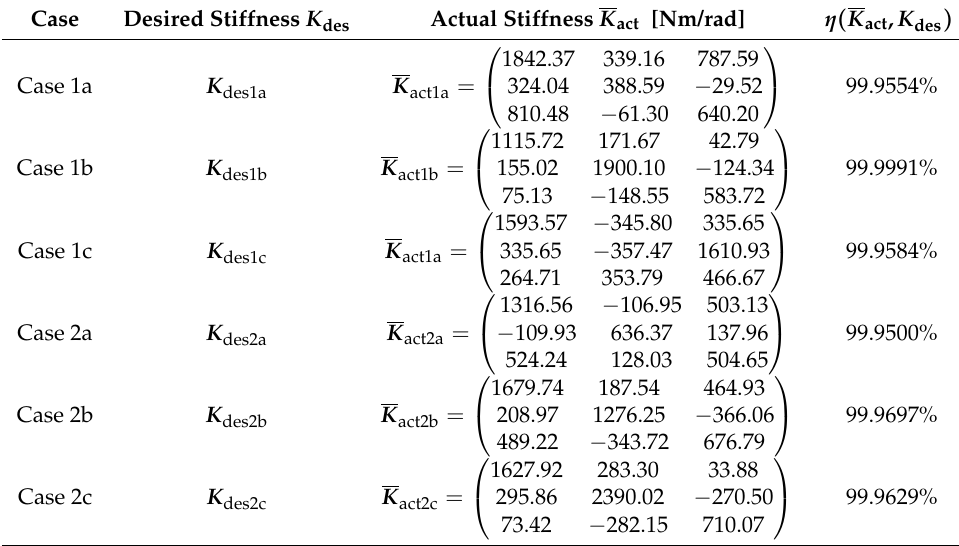
Table 2. Results of the simulation for the six